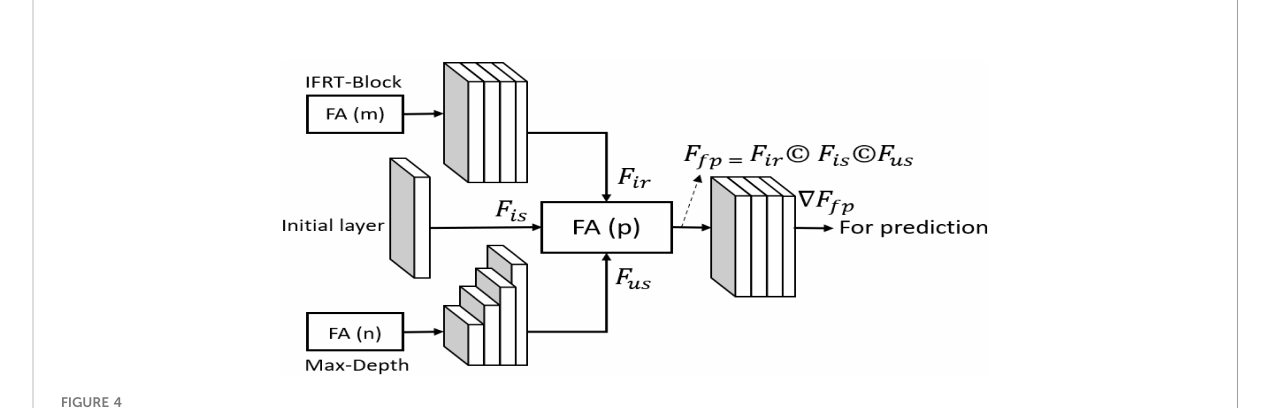
FIGURE 4 Schematic illustrating feature accumulation.